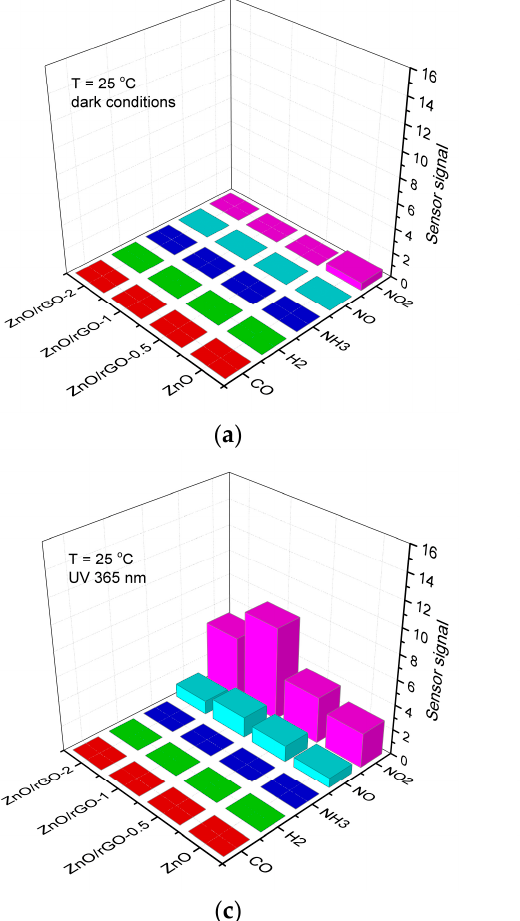
Figure 7. Sensor signal of ZnO nanofibers and ZnO/rGO composites when detecting reducing gases CO, NH 3 , H 2 and oxidizing gases NO and NO 2 in dark conditions ( a , b ) and under constant UV illumination ( c , d ) at T = 25 °C ( a , c ) and T = 150 °C ( b , d ).